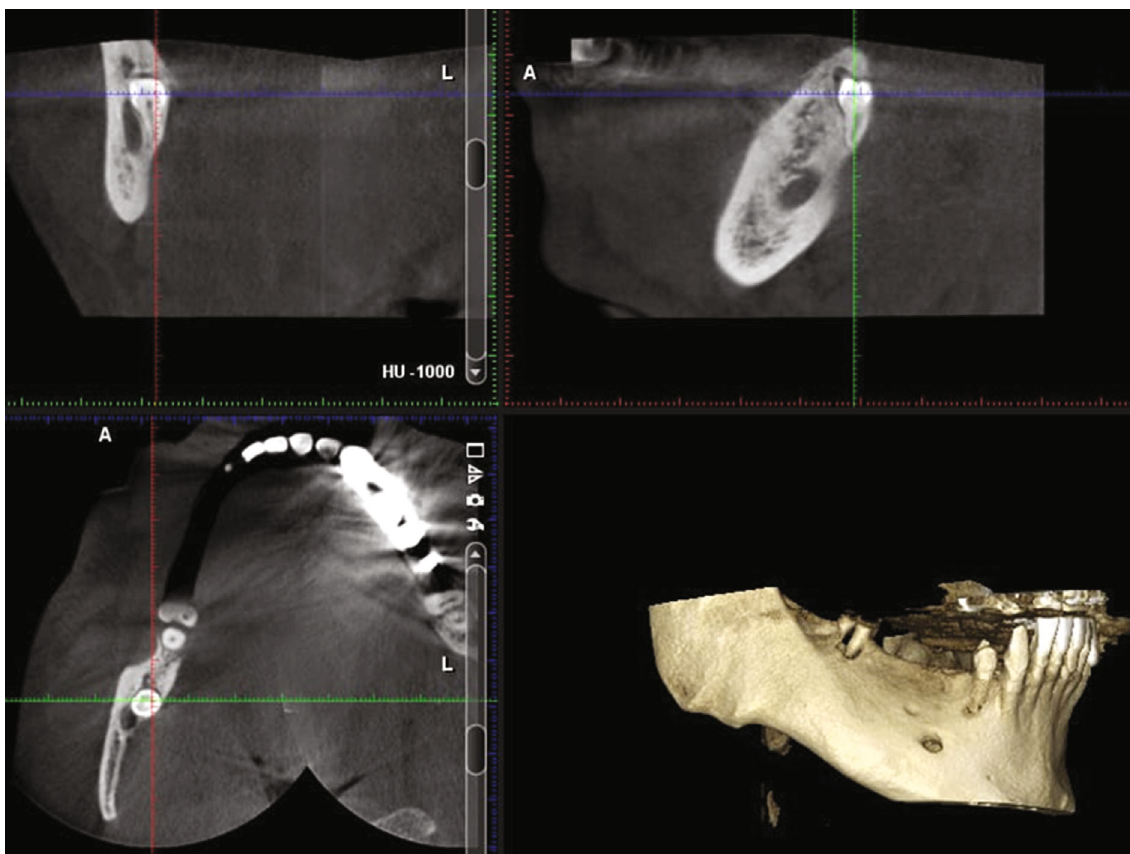
Figure 2: Preoperative CBCT view (coronal, sagittal, axial, and 3D reconstructed